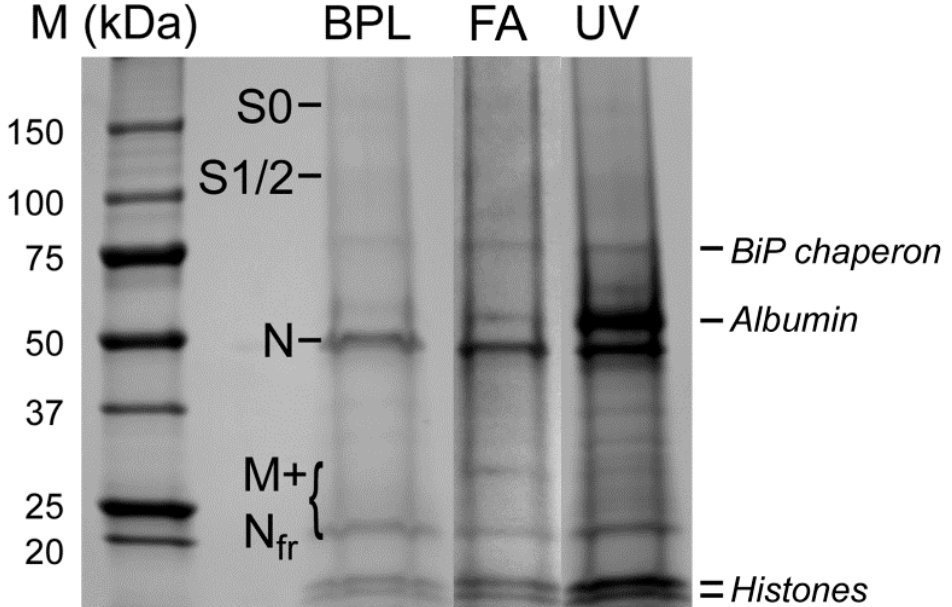
Figure 4. Electrophoregram of preparations of viral particles inactivated by BPL (1:2000 for 36 h), formaldehyde (FA, 2%), or UV-radiation (UV, 3 min). Prior to loading onto the gel, the samples were concentrated via ultracentrifugation through a 20% sucrose cushion. Shown are the positions of SARS-CoV-2 structural proteins: S0—the non-split precursor form of S; S1/S2—cleavage products of S; M—membrane protein; N—nucleoprotein; Nfr—nucleoprotein’s fragments. Some admixed proteins are also indicated: BiP chaperon, albumin, and histones. All proteins were identified using Mascot searches after in-gel trypsin hydrolysis of protein bands, elution of peptides, and their MALDI-TOF-MS analysis.